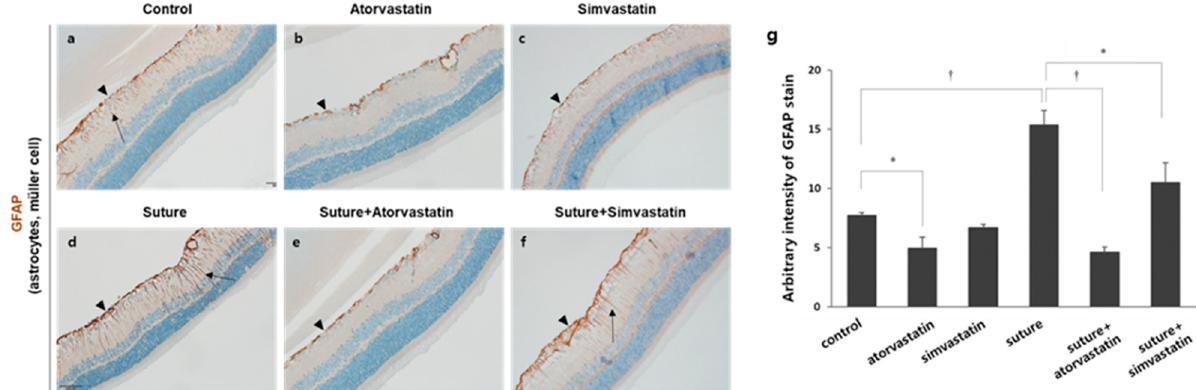
Figure 4. Statins suppress chronic OHT-mediated glial activation in the retina. ( a – f ) The retinal sections were stained with the GFAP antibody expressed in astrocytes and Müller cells. Astrocytes are localized in the NFL (arrowhead), and the processes of Müller cells are found in the IPL (arrow). Substantial upregulation of GFAP expression was observed in sutured retina with GFAP positive processes extending to the IPL and INL, which is suppressed by statins. ( g ) GFAP immunoreactivity was quantified with ImageJ software. * p < 0.05, † p < 0.01; n = 3 for each group. GFAP: Glial fibrillary acidic protein, NFL: nerve fiber layer, IPL: inner plexiform layer, INL: inner nuclear layer, OHT: ocular hypertension.